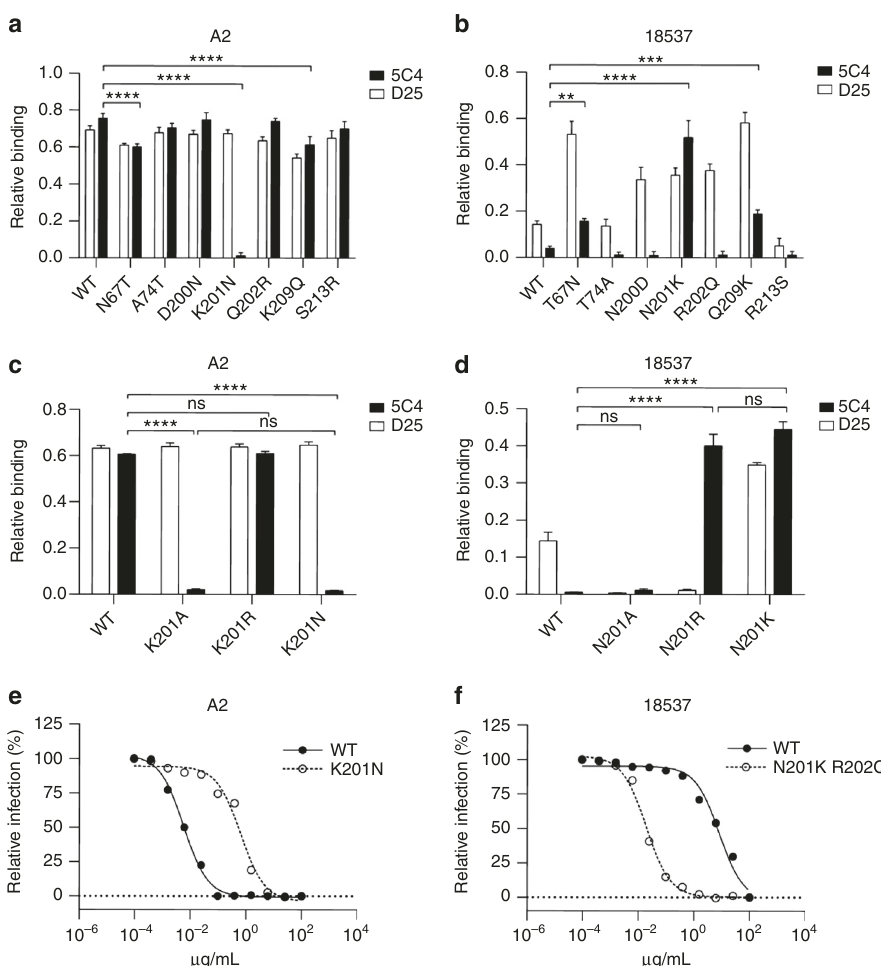
Fig. 4 Arg or Lys at position 201 is critical for RSV F recognition and neutralization by 5C4. a – d Fractional binding of mAbs 5C4 (black bars) and D25 (white bars) to DS-Cav1 – stabilized pre-F variants relative to motavizumab. a Binding to A-chimera constructs (RSV A2 pre-F variants). b Binding to B-chimera constructs (RSV B18537 pre-F variants). c Binding to RSV A2 pre-F position 201 variants. d Binding to RSV B strain 18537 pre-F position 201 variants. Bars represent the standard relative fractional binding of three replicates with error bars indicating standard deviation. P values calculated using two-way ANOVA are shown with symbols, where ns is P > 0.05, ** P ≤ 0.01, *** P ≤ 0.001 and **** P ≤ 0.0001. e , f Neutralization activity of 5C4 against subtype A strain A2 and subtype B strain 18537 with and without subtype-speci fi c substitutions at position 201. e The EC 50 of 5C4 against A2 wild-type and K201N-mutated virus is 0.004 ± 0.0008 μ g/mL (Mean ± SD) and 0.41 ± 0.11 μ g/mL, respectively, from three independent experiments. f The EC 50 of 5C4 against RSV B strain 18537 wild-type and N201K-mutated virus is 9.149 ± 0.056 μ g/mL and 0.022 ± 0.003 μ g/mL, respectively. Data are representative from three independent